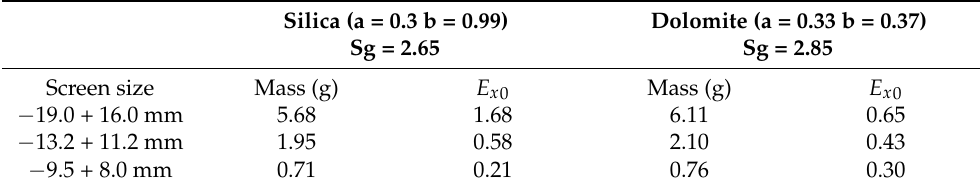
Table 3. Calculated E x 0 values based on previous work [21].